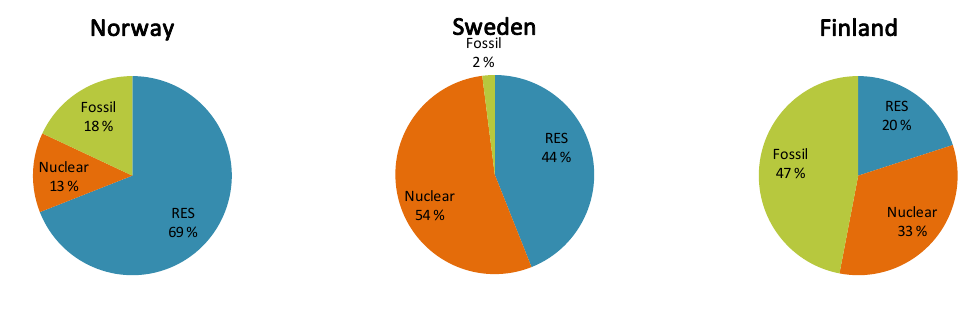
Figure 4. Residual electricity mixes in Norway, Sweden and Finland calculated based on the E-TRACK approach (2008)